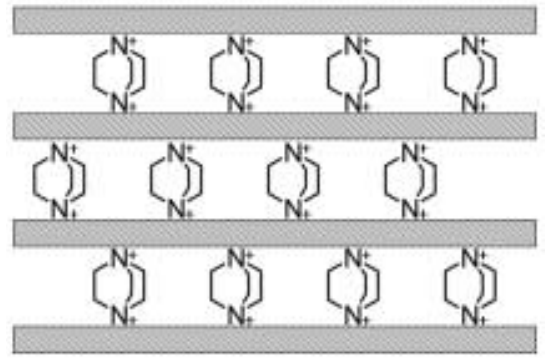
Schematic model of montmorillonite pillared by ethylene- diammonium ions (modified from Montland